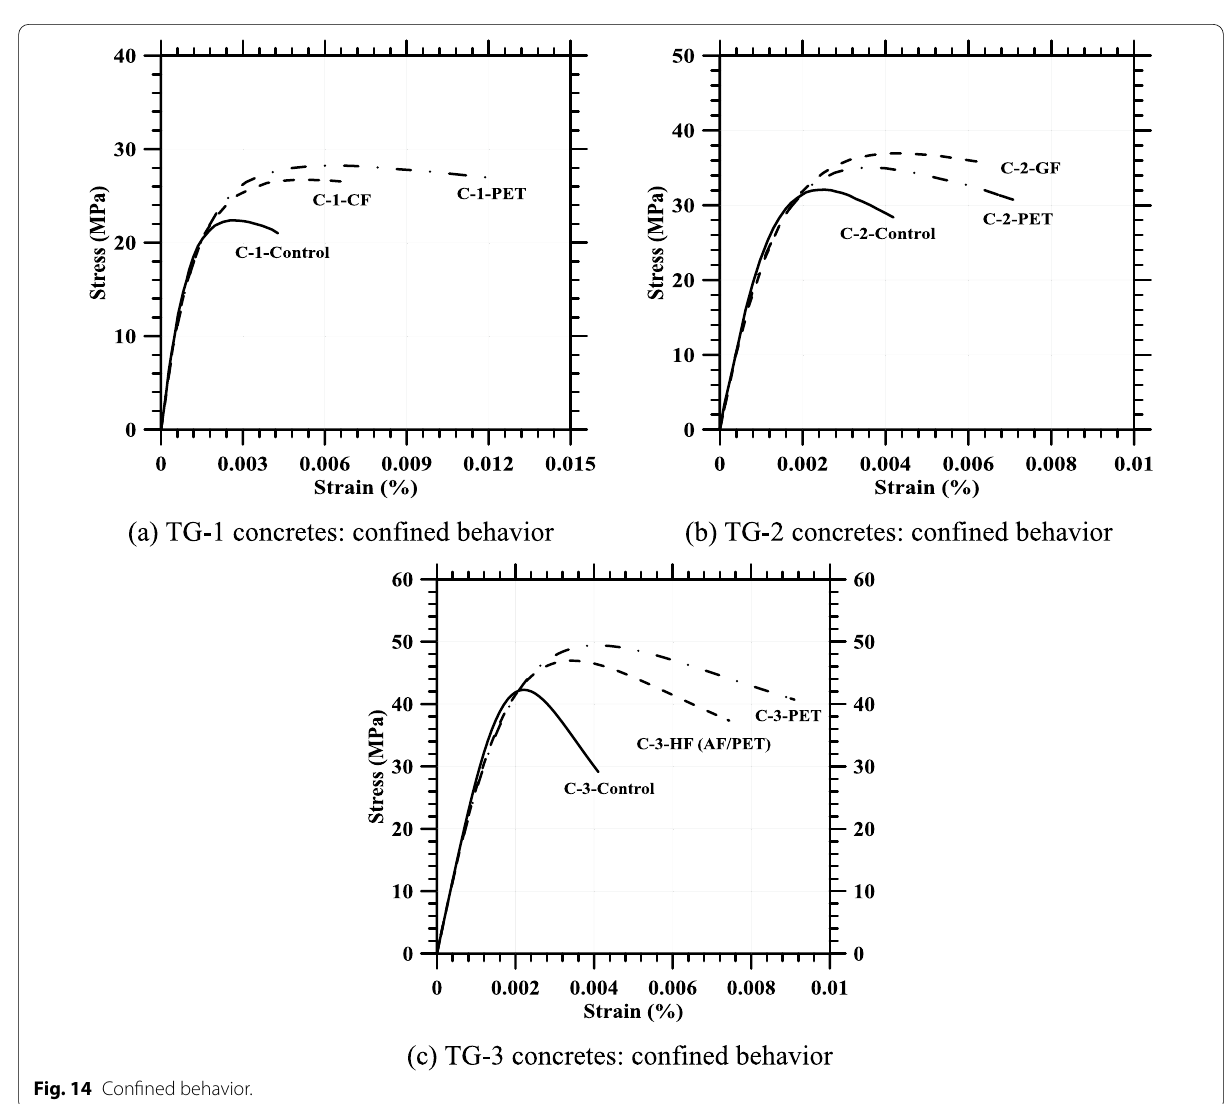
Fig. 14 Confined behavior.